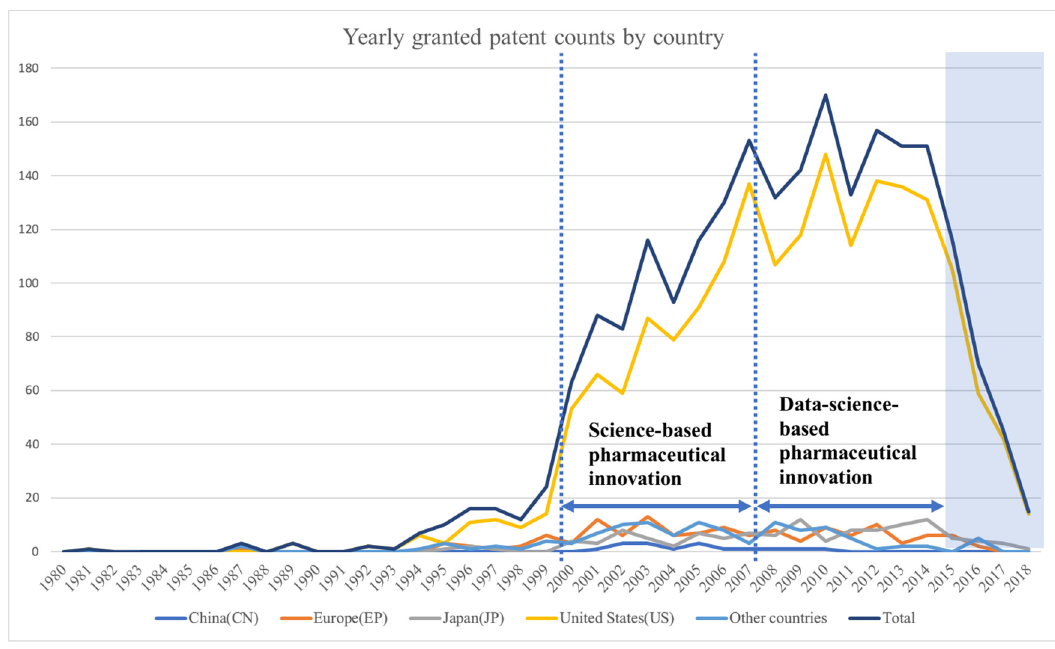
Figure 1. Yearly granted patent counts by country [35].